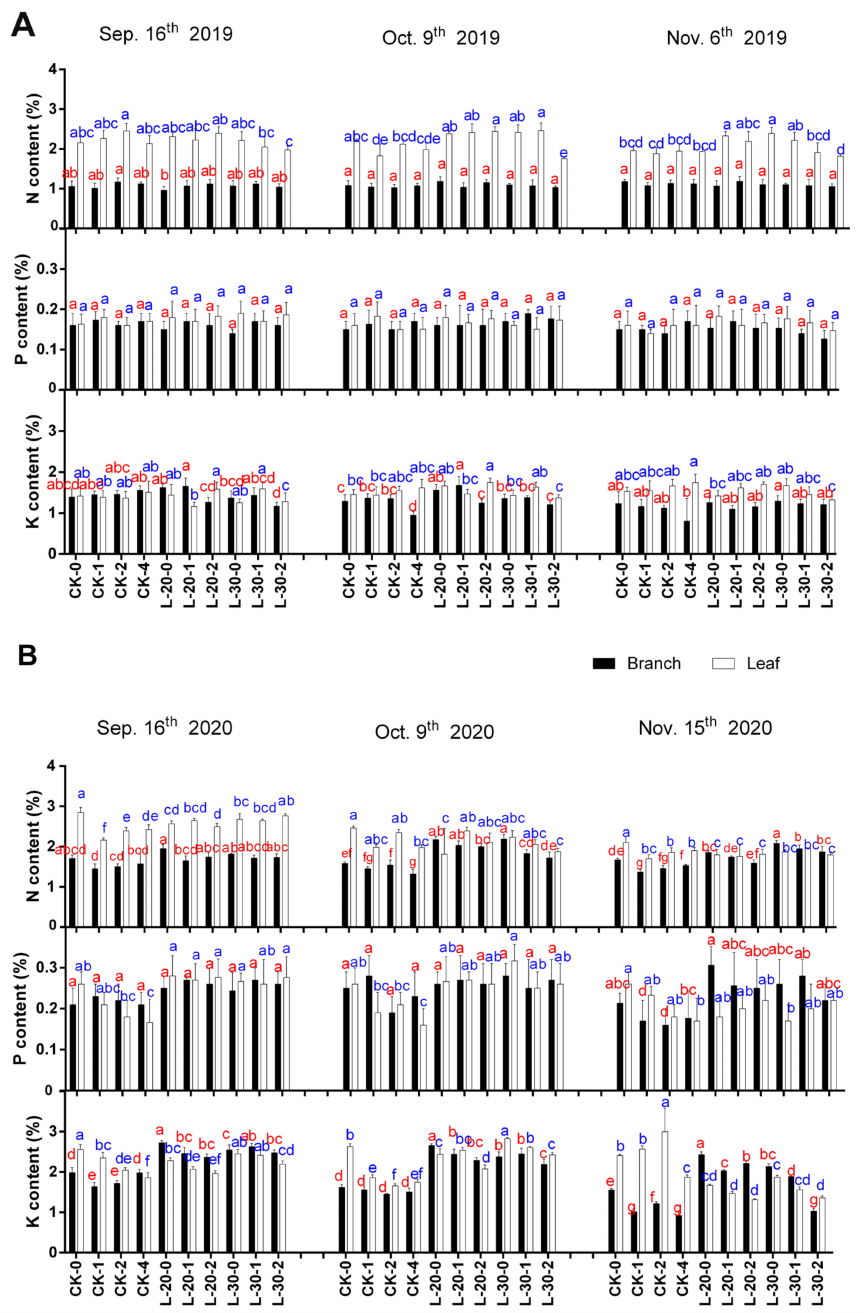
Figure 1. Comparison of changes of NPK contents in branches and leaves under different fruit load treatments from the near-mature period (mid-September) to the fully-mature period (mid-November) during 2019 ( A ) to 2020 ( B ). Within columns, means with the different letter indicate significant differences ( p < 0.05) using Duncan’s test; bars on the columns represent the standard error of the mean ( n =